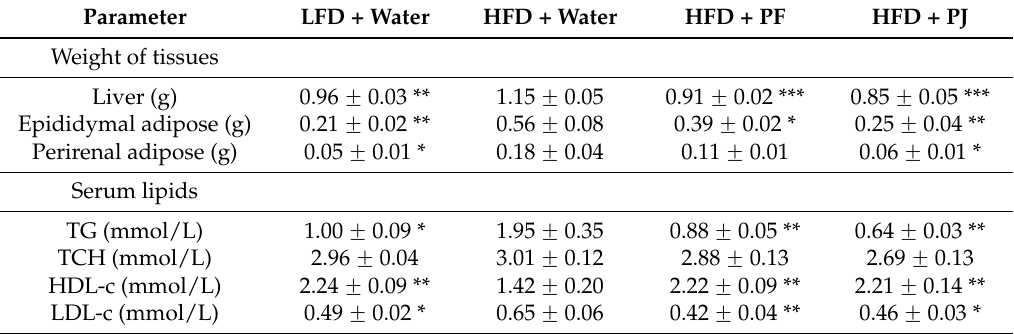
Figure 2. Effects of PF and PJ extracts (40 mg/kg body weight, respectively) on body weight ( A ) and